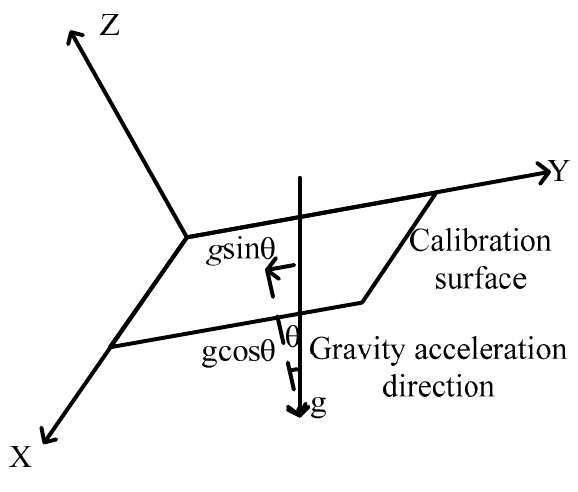
Figure 5. This is a schematic diagram of the deviation of the calibration surface from the direction of gravity’s acceleration.